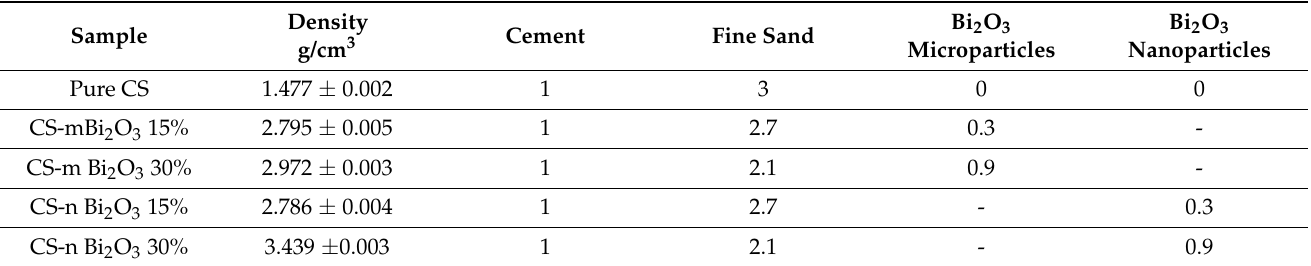
Table 2. Mixing mass ratio of mortar